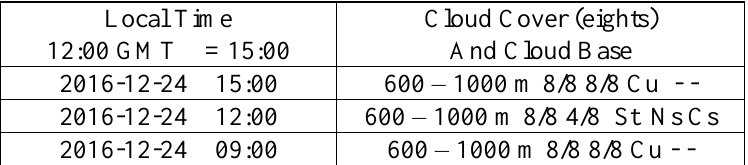
Table 7: Surface weather forecast for Kirkuk.